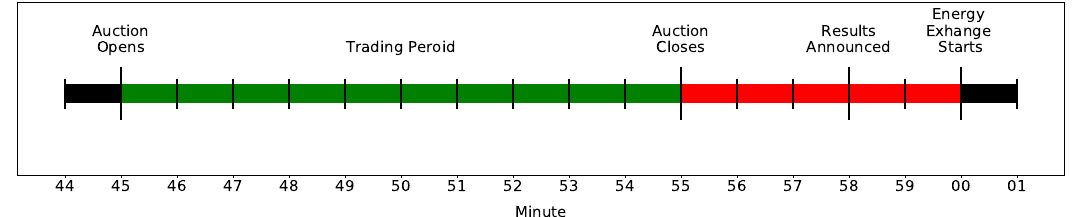
Figure 1. The market timeline shows when agents submit their bids and asks and when the facilitator announces the results. Exchanging energy based on the results occurs at the start of every hour. The hourly bills are calculated at the end of each